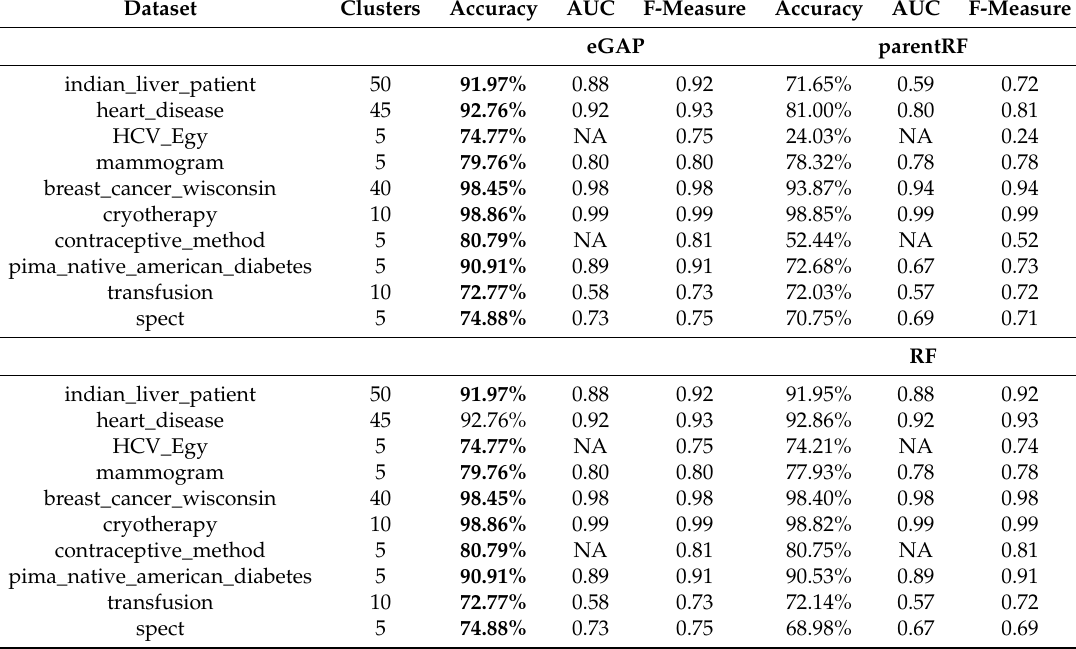
Table 5. Performance metrics of eGAP vs. parentRF, Random Forest (RF), and CLUB-DRF on classification datasets. (Figures in bold indicate the highest